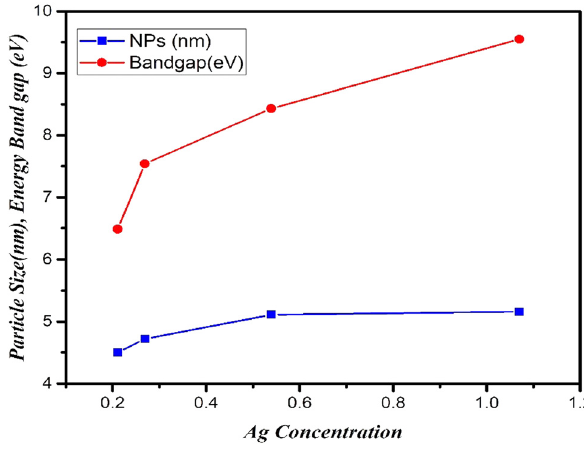
Figure 7: Ag concentration with particles size and band gap energy of pure PbS and